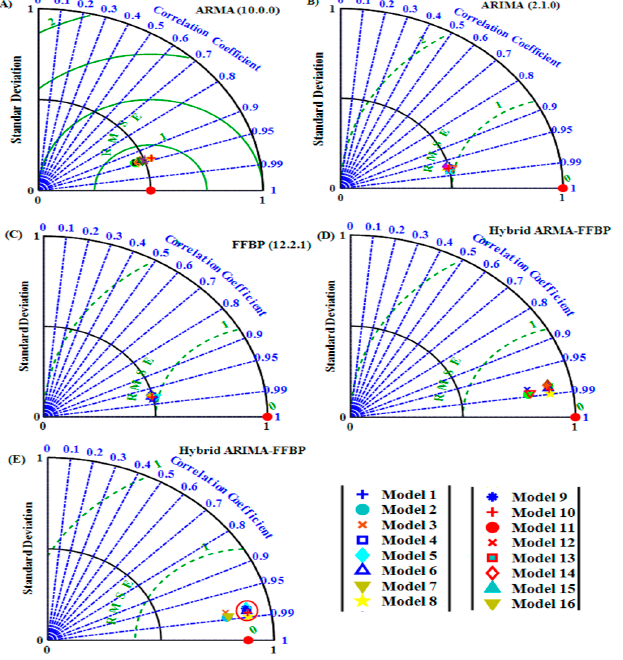
Figure 11. Taylor diagram of several ( A ) ARMA, ( B ) ARIMA, ( C ) FFBP, and ( D , E ) hybrid models of Tetouan city.